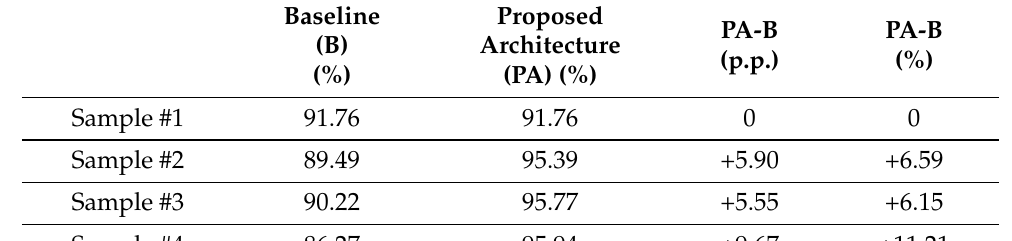
Table 8. Precision results of Baseline and Proposed Architecture scenarios